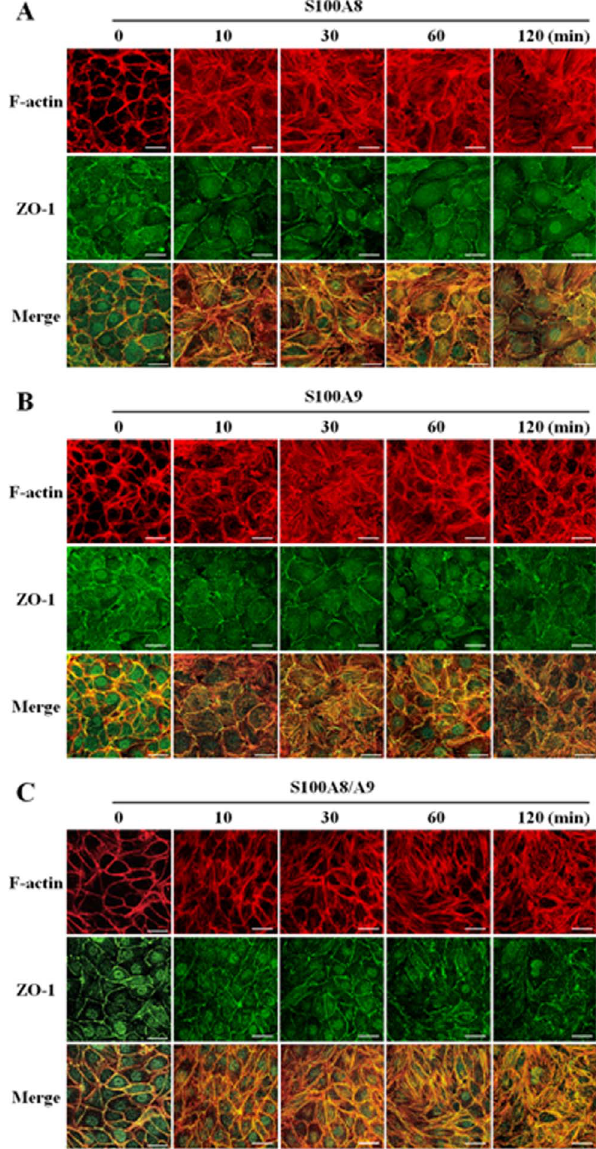
Figure 2. S100A8, S100A9 and S100A8/A9 induced stress fiber formation and disrupted ZO-1. HUVECs grown on Petri dishes were incubated with S100A8 (2.0 m g/mL) ( A ), S100A9 (2.0 m g/mL) ( B ) and S100A8/A9 (2.0 m g/mL) ( C ) for 0, 10, 30, 60 and 120 min respectively. Cells were fixed, and double immunofluorent staining was performed according to the protocol described in Materials and Methods. Cells were probed with rodamine-conjugated phalloidin to detect actin filaments (Red) and with ZO-1 antibody to label tight junctions (Green). Scale bar, 30 m m. Results are representative of three independent